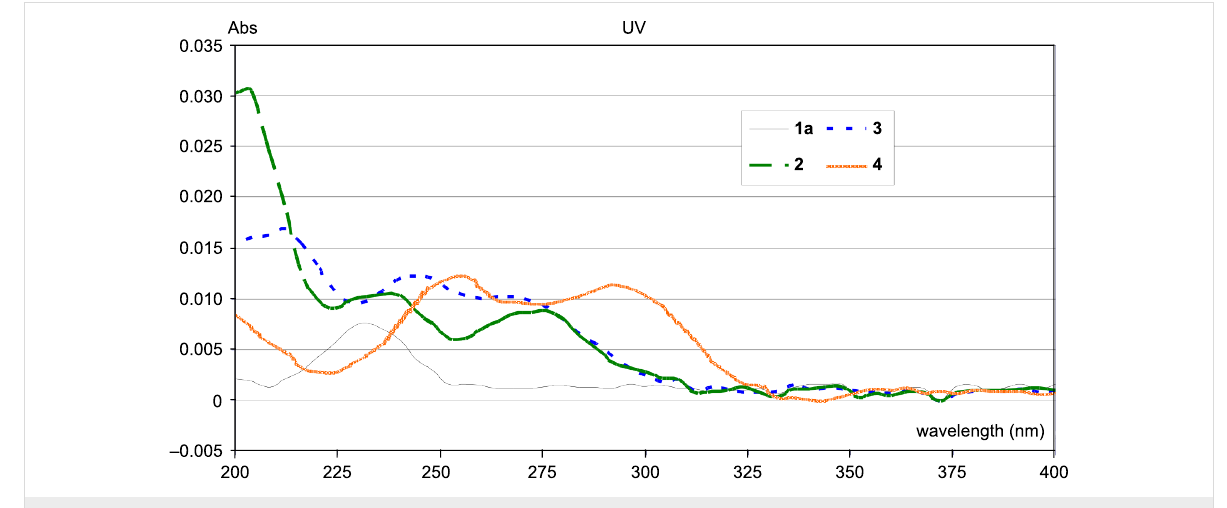
Figure 3: UV–vis spectra of SAMs of compounds 1a , 2 , 3 and 4 .